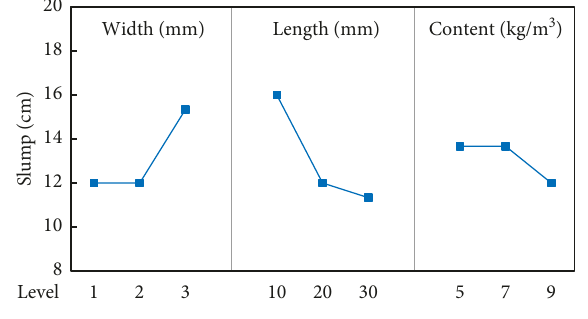
Figure 5: Main effect plot for slump.